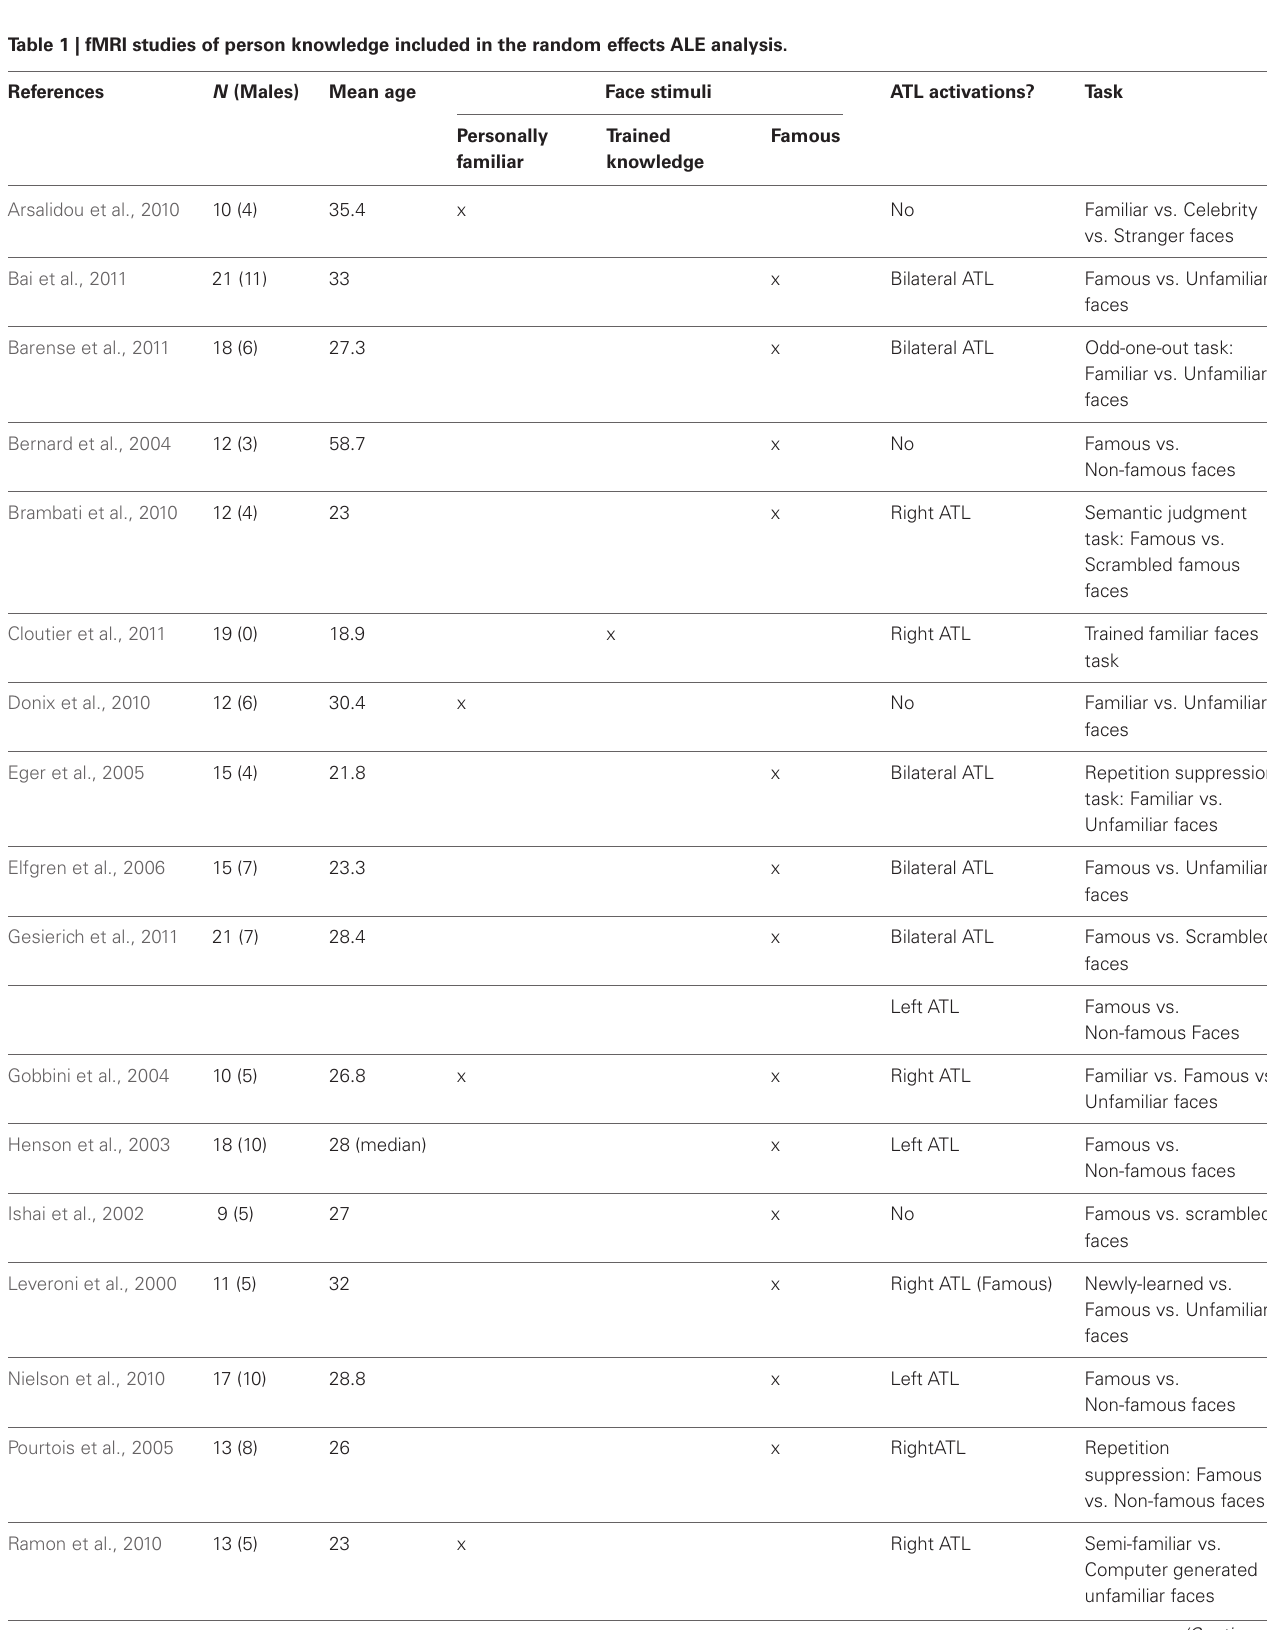
Table 1 | fMRI studies of person knowledge included in the random effects ALE